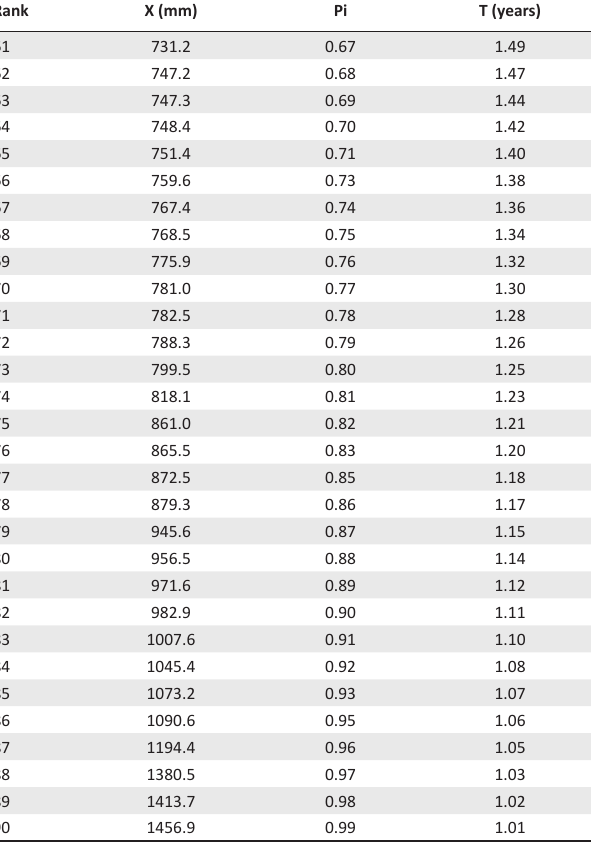
TABLE 4 (Continues...): Rainfall totals, plotting positions and return periods of maize prone to agricultural drought in the growing period of December to February in the rainfall zone